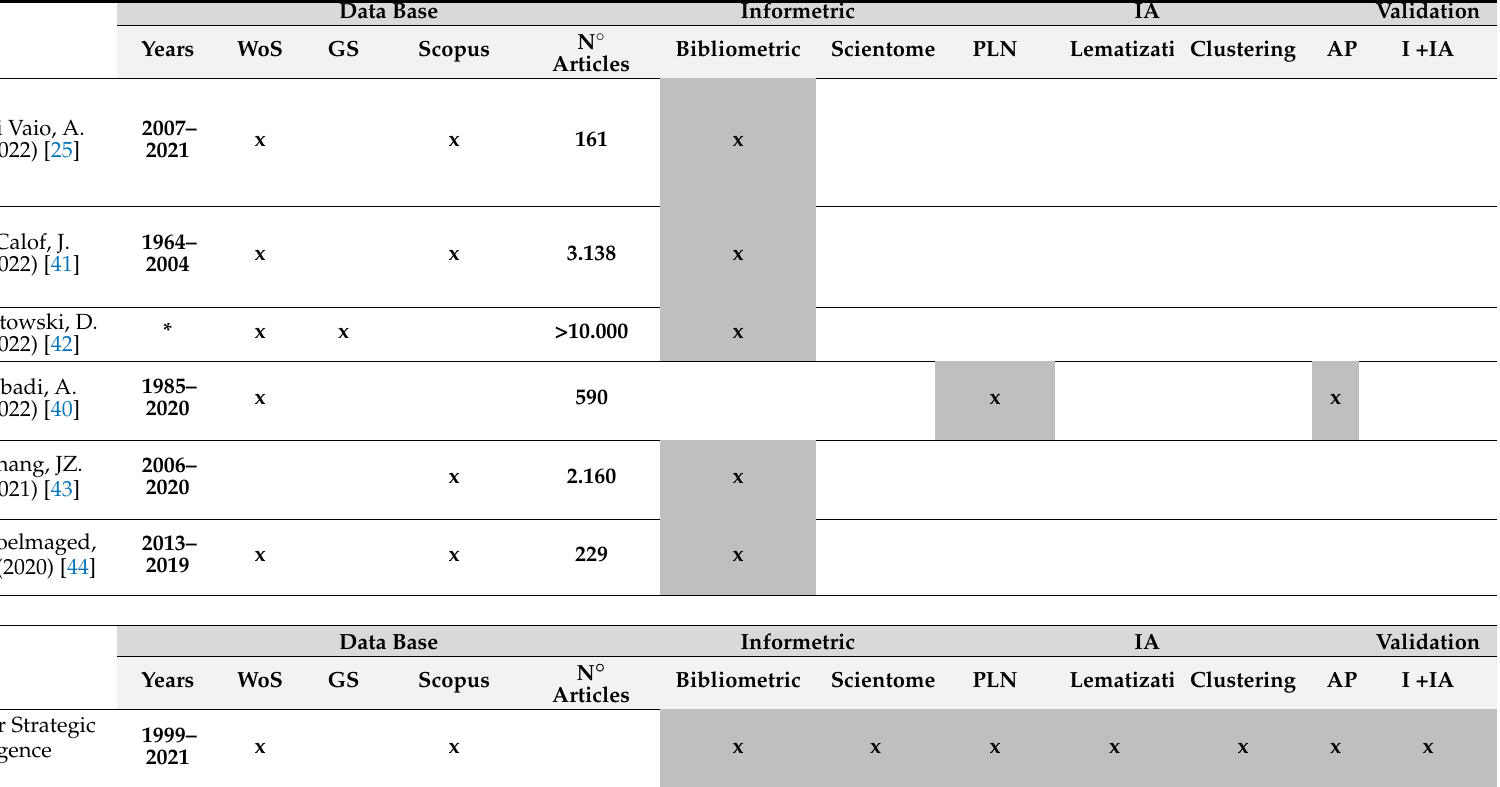
Table 1. Analysis of methodologies applied in the study on leadership competencies with BI&A, own